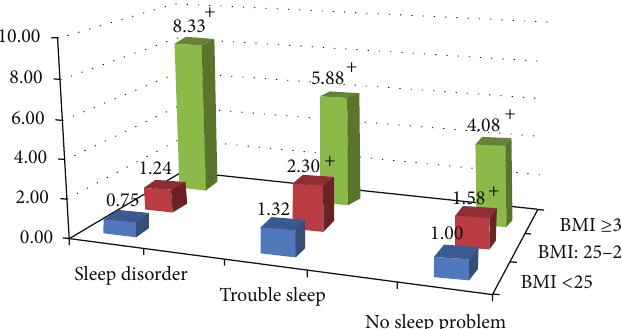
Figure 1: The ORs of diabetes by different combinations of sleep and obesity status after adjustment for age, gender, race, education, ratio of family income to poverty, marital status, total to HDL cholesterol ratio, systolic blood pressure, sedentary activity time, alcohol drinking, cigarette smoking, C-reactive protein, and sleep duration. The group of BMI < 25.0 with no sleep problem is the reference group. + 𝑃 value <